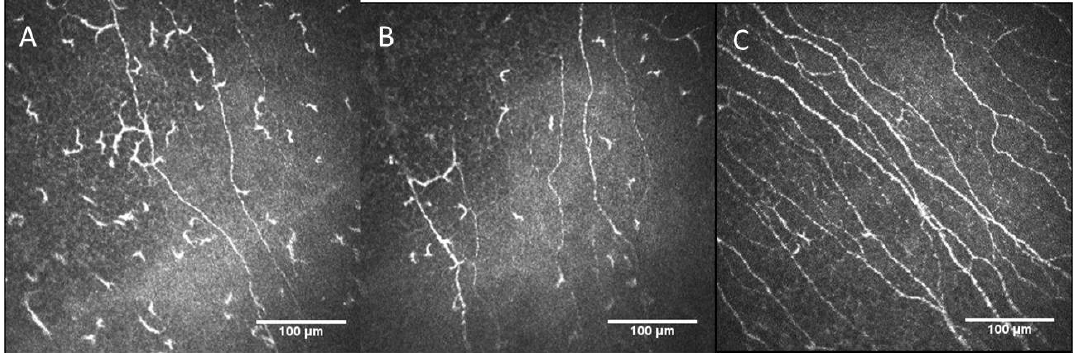
Figure 2. ( A ) Dendritic cell population in affected patient RE; ( B ) dendritic cell population in af- fected patient LE; ( C ) dendritic cell population in a patient without systemic pathologies or refrac- tive surgery. RE: right eye; LE: left eye. Regarding all the confocal results, the patient showed the criteria of involvement of small fiber neuropathy (SFN) in the context of an infectious episode ( B. Miyamotoi ). The presence of a decrease in unmyelinated fibers with abundant presence of dendritic cells (DCs) in the cornea supports this diagnosis. At hemodynamic level, very low blood pressure with low levels of norepinephrine in prone position also support the SFN. There was no sensory deficit on QST, but thermal allodynia persisted. 3. Discussion One Lyme disease variant is caused by B. Miyamotoi . Regarding its epidemiology, there is limited knowledge of the full geographic distribution of human B. Miyamotoi in- fection, but it is likely to be similar to the Lyme disease variant caused by B. Burgdorferi [7]. Although the most commonly reported clinical presentation of B. Miyamotoi infection is a febrile illness with fatigue, headache, myalgia, arthralgia, etc. [22], in late stages, clinical presentation may show chronic neurologic symptoms, primarily cognitive dis- turbances or small fiber peripheral neuropathy (as spinal radicular pain or distal pares- thesias or hypoesthesia) [23]. This type of Lyme disease is also called Lyme neuroborre- liosis. The cornea has two main types of nerve fibers: the A-delta (A δ ) and the C nerve fi- bers. The A δ are high speed myelinated fibers (conduction average velocity of 6 m/s), and they represent about 20% of the total density of corneal afferent fibers. The C fibers are